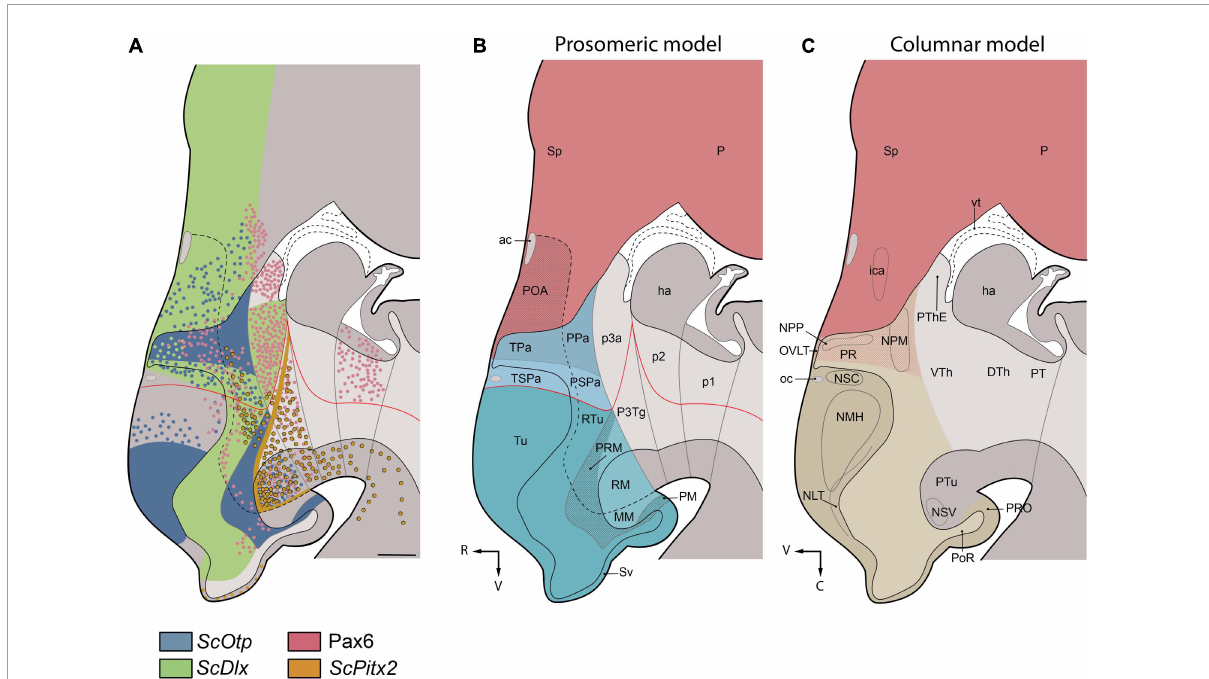
FIGURE6 Parasagittal schematic representation of Scyliorhinus canicula hypothalamus at stage 32 based on the expression patterns of developmental genes (A) and comparison of the regionalization of the S. canicula hypothalamus according to prosomeric (B) and columnar (C) frameworks. For reference, the ventricle line has been drawn at midline (sagittal) level. (A) Maximal projection of the expression of ScOtp (blue) ScDlx2 (green), Pax6 (red) and ScPitx2 (orange) found in sagittal and parasagittal sections (B) Prosomeric subdivisions in the hypothalamus and surrounding tissues. Telencephalon is represented in red; different domains of the hypothalamus are represented in different shades of blue. The red line represents the postulated alar-basal boundary. According to this model, the hypothalamus excludes the POA, lies ventral (V) to the telencephalon and rostral (R) to the diencephalon. (C) Hypothalamus, according to the columnar model and approximate location of main cell masses as described in the adult shark by Smeets et al. (1983). Telencephalon is represented in red; hypothalamus is represented in brown. According to the columnar model, the hypothalamus is located caudal (C) to the telencephalon and is conceived as the ventral (V) part of the diencephalon. Note that NPP and NPM (red shaded area) were considered in Smeets et al. (1983) as belonging morphologically to the telencephalon, but they were described together with other hypothalamic cell masses because of their functional relationship to the hypothalamohypohyseal system. For abbreviations, see